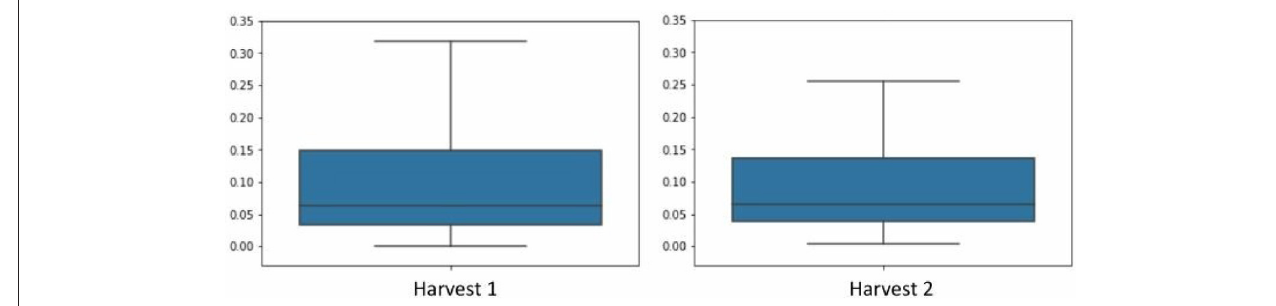
FIGURE 5 | Distribution of averages of each marker for each of the